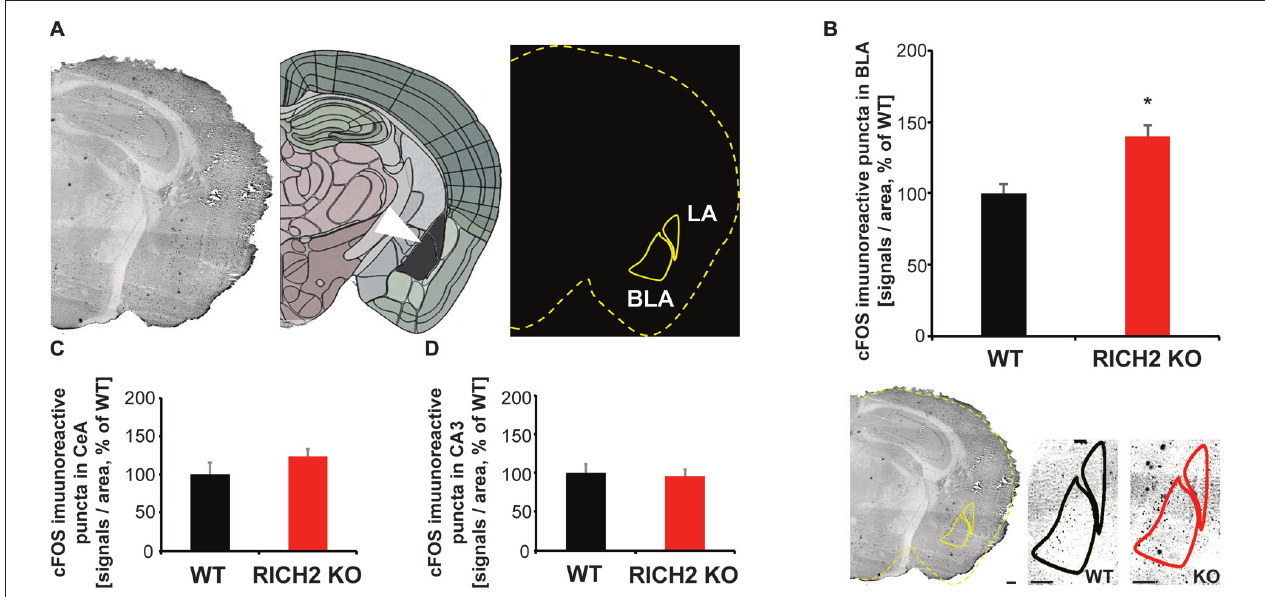
FIGURE 4 | Altered neuronal activation in amygdala of RICH2 KO mice in response to novel objects. (A) c-FOS staining was performed 30 min after the novel object test. An overlay mask was made outlining the brain section and location of basolateral amygdala (BLA) and CeA using the mouse brain atlas at approximately Bregma − 2.8. The mask was merged with the scanned slices and the number of immunoreactive signals within the BLA and CeA region was counted. (B) The number of c-FOS stained cells is significantly increased in the amygdala (BLA) of RICH2 KO mice (Unpaired t -test, p = 0.0169, n = 3 per group). (C) A non-significant increase was detected in the CeA. (D) As control, c-FOS staining was evaluated in the hippocampal CA3 region. No significant difference between WT and RICH2 KO mice was detected. CeA, central amygdala; LA, lateral amygdala; BLA, the lateral (LA) and basal (BA) nuclei (together referred to as the basolateral amygdala—BLA). Scale bar = 300 µ